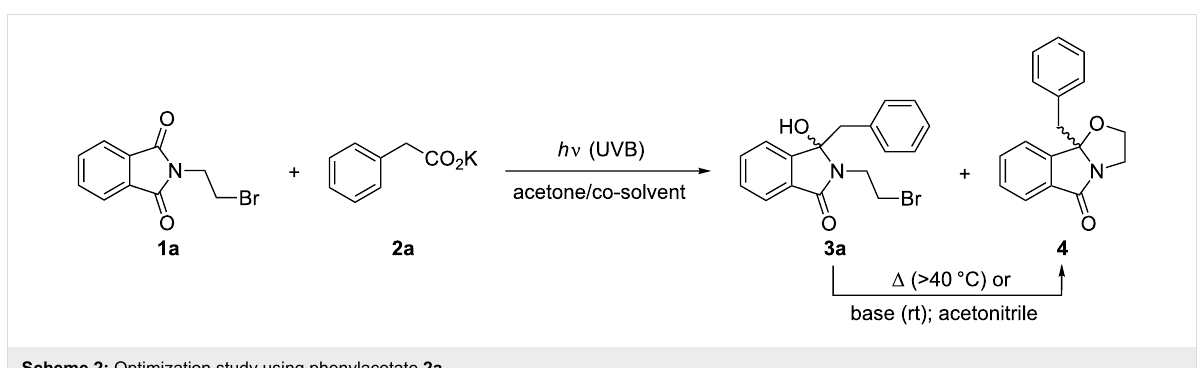
Scheme 2: Optimization study using phenylacetate 2a